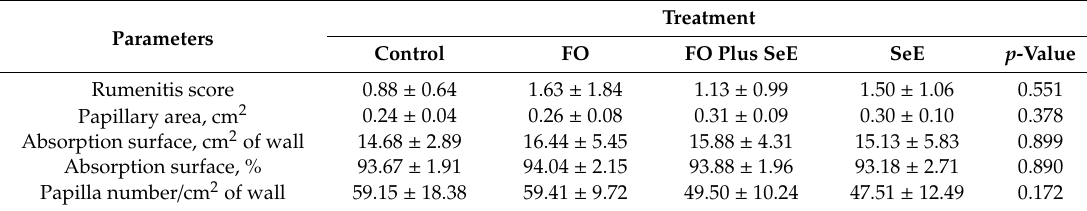
Table 3. Rumenitis incidence and ruminal morphology parameters (means ± s.d.) of Dorper x Santa Ines lambs fed a high-concentrate diet with di ff erent